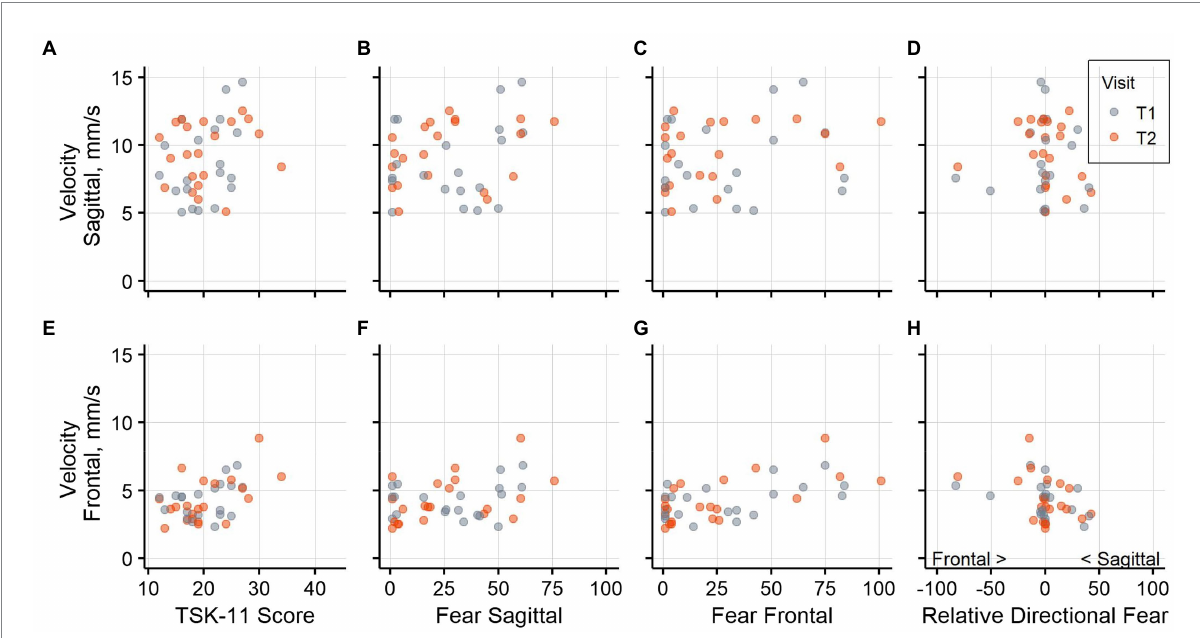
FIGURE 4 Postural sway velocity and fear. Association of postural sway velocity in the sagittal plane and (A) general fear, (B) fear of sagittal plane movement, (C) fear of frontal plane movement, (D) relative directional fear. Association of postural sway velocity in the frontal plane (E) general fear, (F) fear of sagittal plane movement, (G) fear of frontal plane movement, (H) relative directional fear. Negative values for relative directional fear show higher fear of frontal plane movements and positive values show higher fear of sagittal plane movements. Data from assessment visit T1 is shown in blue and data from T2 in